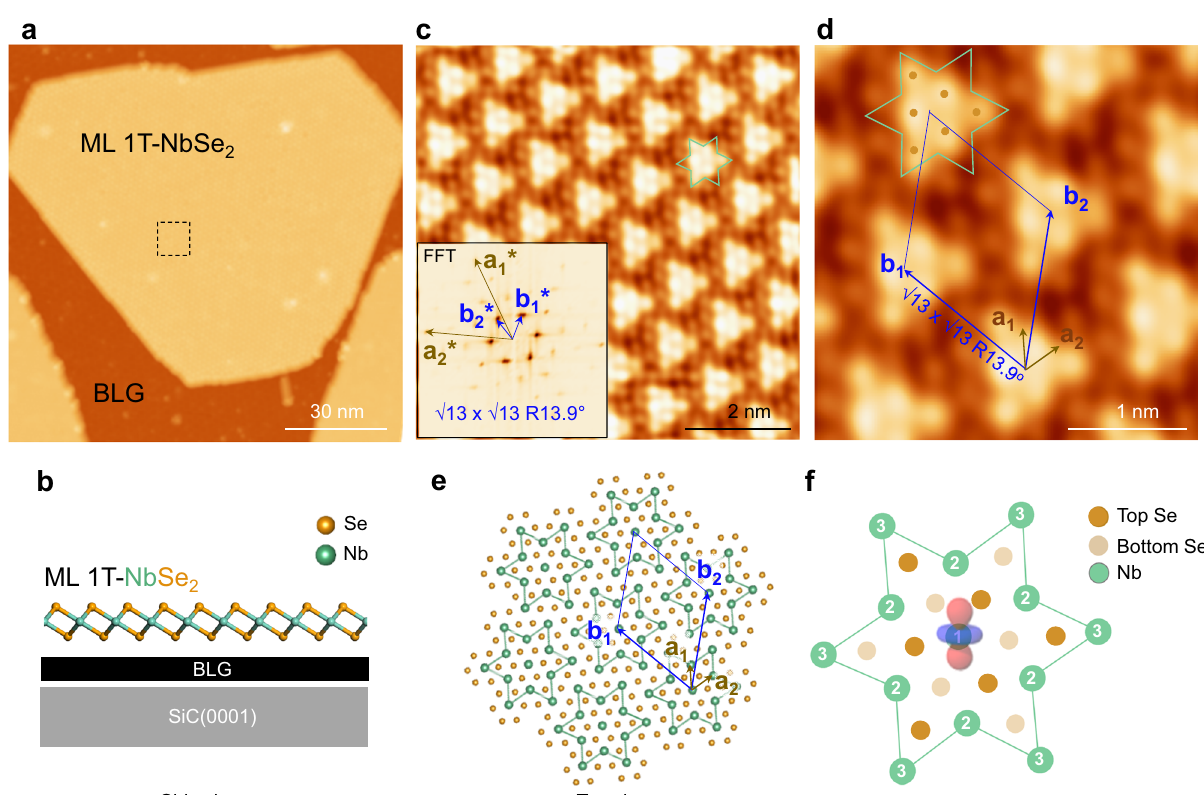
Fig. 1 Large-scale and high-quality monolayer 1T NbSe 2 with “ Star of David ” (SOD) CDW pattern. a Large-scale STM image of MBE-grown NbSe 2 islands on BLG/SiC(0001), showing ML 1T-NbSe 2 island with edge length 120 nm at the center. b Side view of schematic atomic model of ML 1T-NbSe 2 on BLG/SiC(0001) substrate. c Zoomed-in image of dashed black square in a showing both CDW pattern and atomic resolution of ML 1T-NbSe 2 surface. Inset shows FFT image. d Zoomed-in image showing basis vector of CDW unit cell (with unit vectors b 1 and b 2 ) and atomic lattice of Top-Se layer (with unit vectors a 1 and a 2 ); the SOD (green star) was imaged as six top Se atoms (brown dots). e Top view of atomic model of NbSe 2 , showing SOD pattern and rhombus unit cell. f SOD model showing 13 Nb atoms at three different equivalent sites with six-fold symmetry. Central Nb atom (Nb1) labeled with schematic d z 2 orbital to indicate spatial distribution. Scanning parameters: a bias voltage V B = − 1.5 V, tunneling current I t = 20 pA; c and d , V B = − 1.5 V, I = 500 t